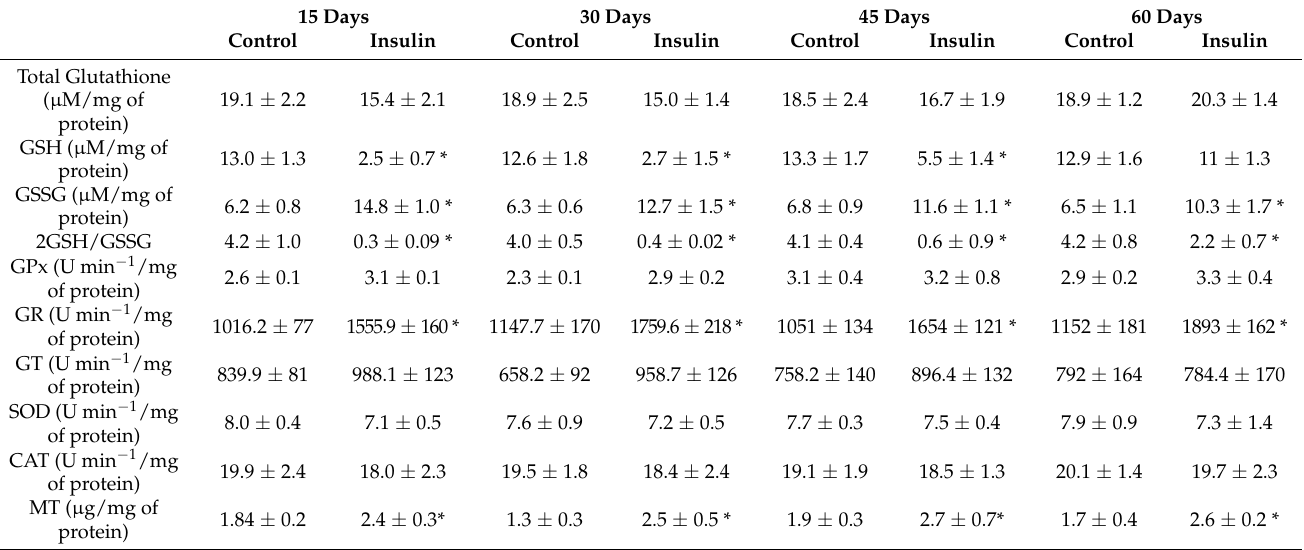
Table 3. Hepatic antioxidant